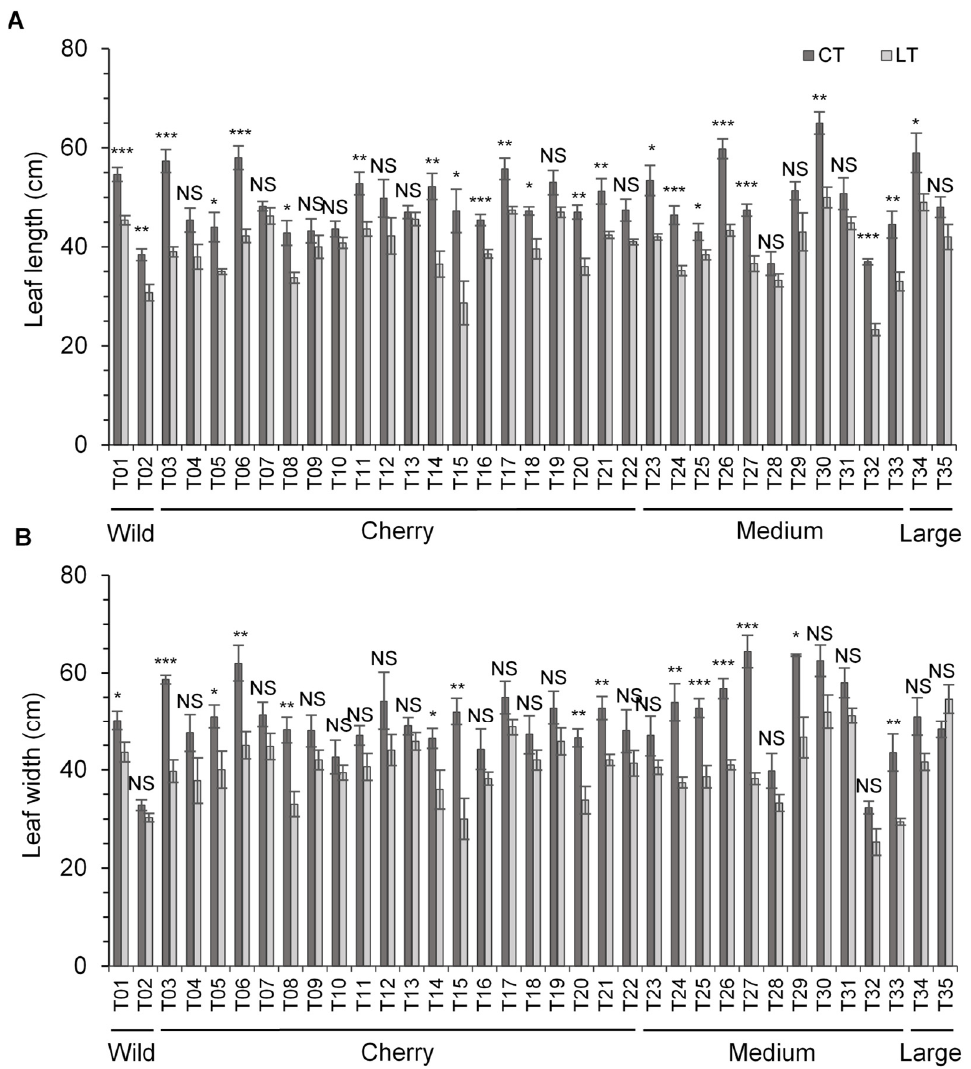
Figure 2. The analysis of vegetative traits on ( A ) leaf length and ( B ) leaf width among 35 tomato accessions with different fruit types under CT and LT greenhouses. Leaf length and width were measured at 70 days. Significant differences were evaluated with Student’s t -test ( p ≤ 0.05, p ≤ 0.01, and p ≤ 0.001) and are denoted by *, **, and ***, respectively. NS indicates not significant and bars indicate ± standard deviation ( n = 5).